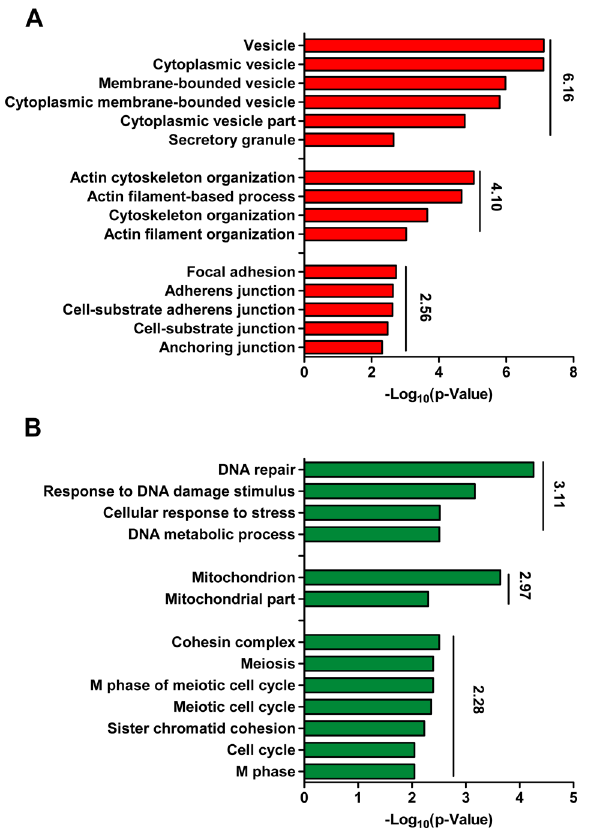
Fig 1. GO analysis with identified gene signatures. 579 genes were identified after analyzing 74 human and 31 mouse EMT-induction samples as described in Materials and methods. 378 up-regulated and 201 down-regulated genes were subjected to GO analysis, and enriched GO terms were listed in (A) and (B). The average – log 10 (p-Value) is shown next to the bar plots.